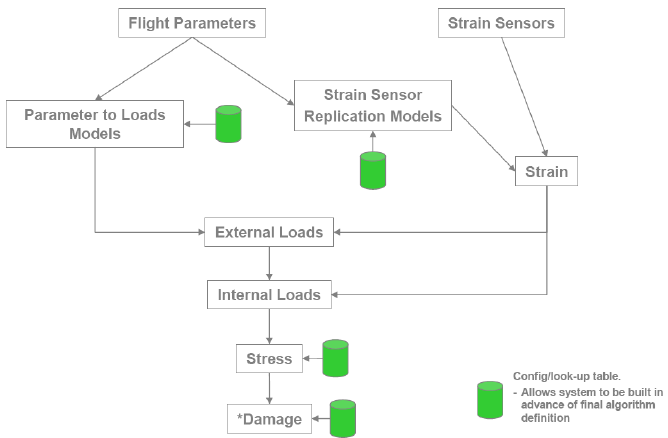
Figure 3. Flowchart of load monitoring for F-35.